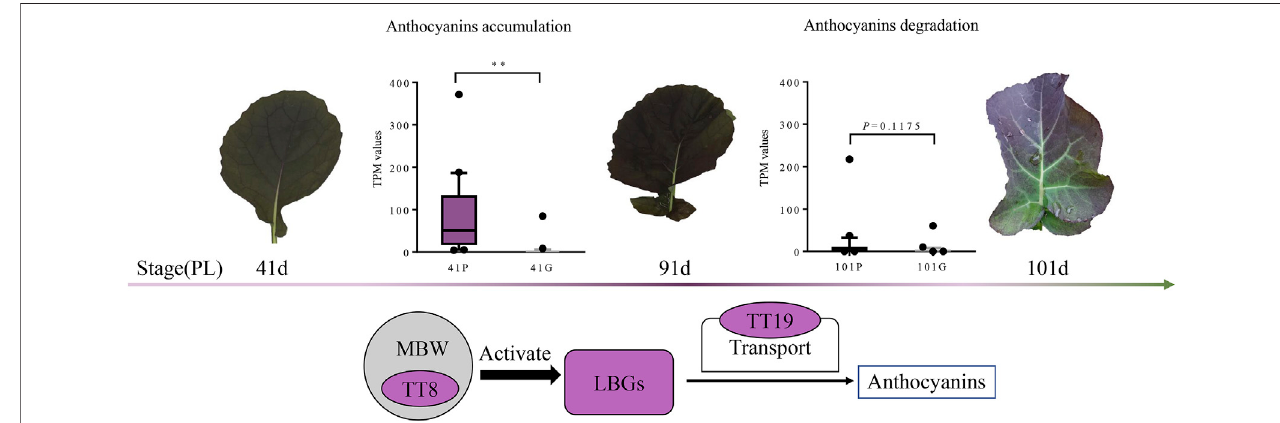
FIGURE5| Modelofanthocyaninsaccumulationin Brassicanapus .The TT8 , TT19 ,andLBGsaresigni fi cantlyexpressedinPLcomparedwiththoseinGLfrom41 to 91 days, ( p < 0.01). At these developmental stages, anthocyanin contents increase, and the purple pigments are accumulated in the adaxial epidermis and subepidermal cells. The expression levels of these genes are decreased in PL and exhibited no signi fi cant difference between that of GL from 91 to 101 days, ( p (cid:1) 0.1175). The anthocyanin degradation at this developmental stage might reduce the total anthocyanin accumulation and result in the leaves to gradually turn to green. Circles fi lled with purple color indicate upregulated genes expressed in PL at 41 and 91